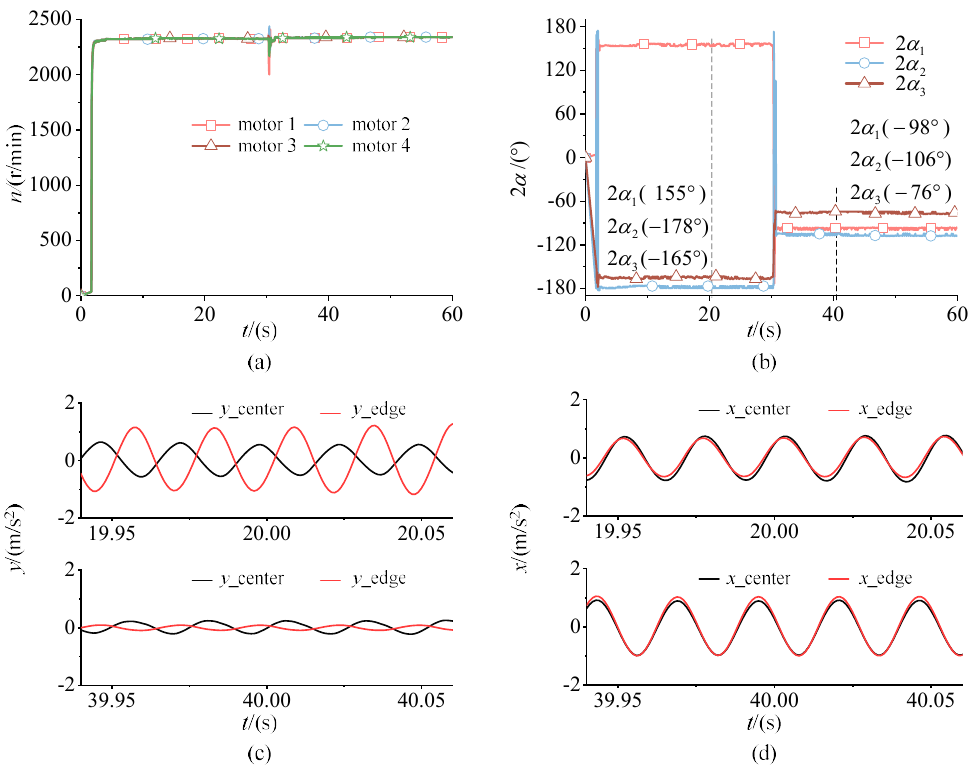
Figure 12. Phase differences of ERs change from 180 ◦ to 90 ◦ with disturbance: ( a ) Synchronous velocities of four ERs; ( b ) Phase differences; ( c ) Acceleration amplitude in y direction at 20 s and 40 s; ( d ) Acceleration amplitude in x direction at 20 s and 40